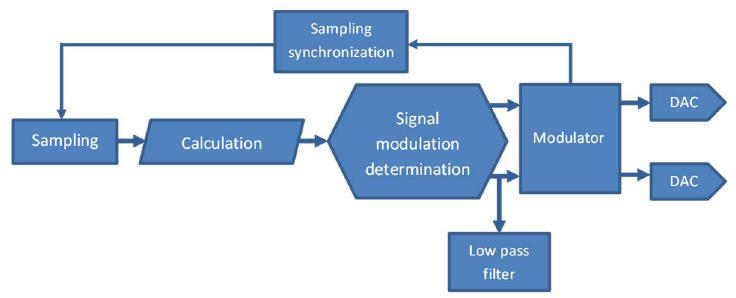
Figure 3. General structure of FOS6’s software.